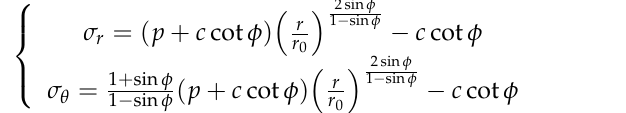
where φ is the internal friction angle of the rock (assigned the value of 29 ◦ ), σ r is the radial stress, σ θ is the circumferential stress and c is the cohesion force, which is taken to be 0.12 MPa. can be divided into a circumferential plastic zone and a circumferential elastic zone outside the plastic zone. The formula for stress distribution in the elastic zone is as follows: